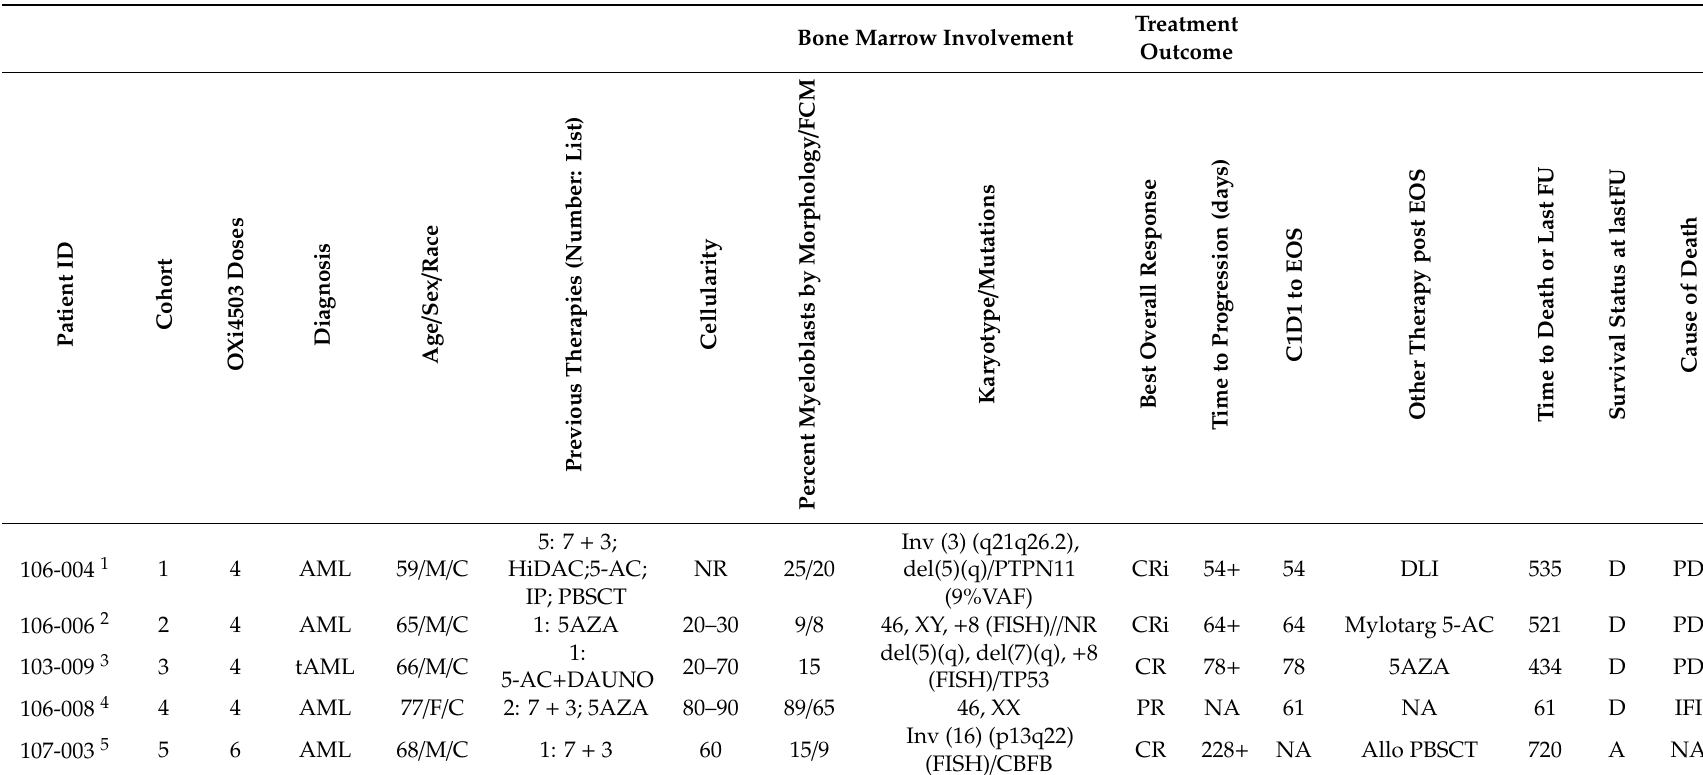
Table 4. Relapsed AML Patients Who Had an Objective Response to OXA in OX1222 Study ( N = 5). Treatment Bone Marrow Involvement